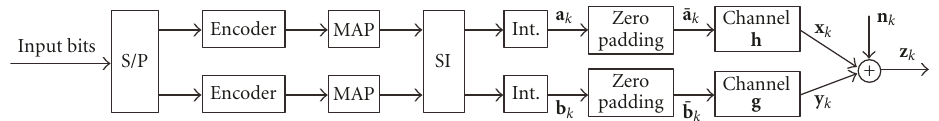
Figure 5: Space-time diversity with the threaded layered space-time (TST) architecture.